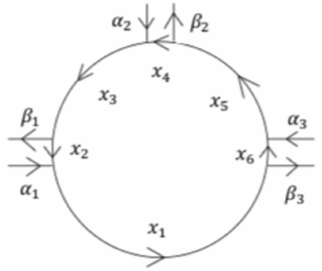
Figure 1. The roundabout